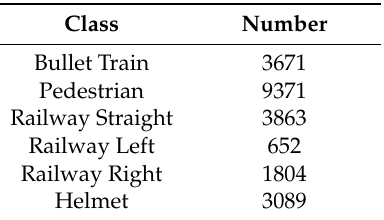
Table 2. The number of each class in the dataset.